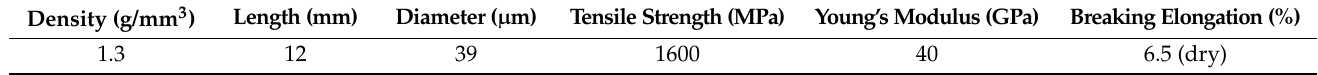
Table 1. Properties of PVA